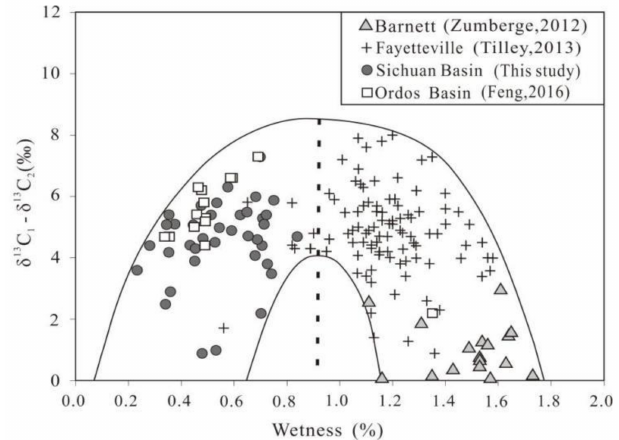
Figure 1. Relationship between wetness and δ 13 C 1 – δ 13 C 2 of the shale gas with isotope